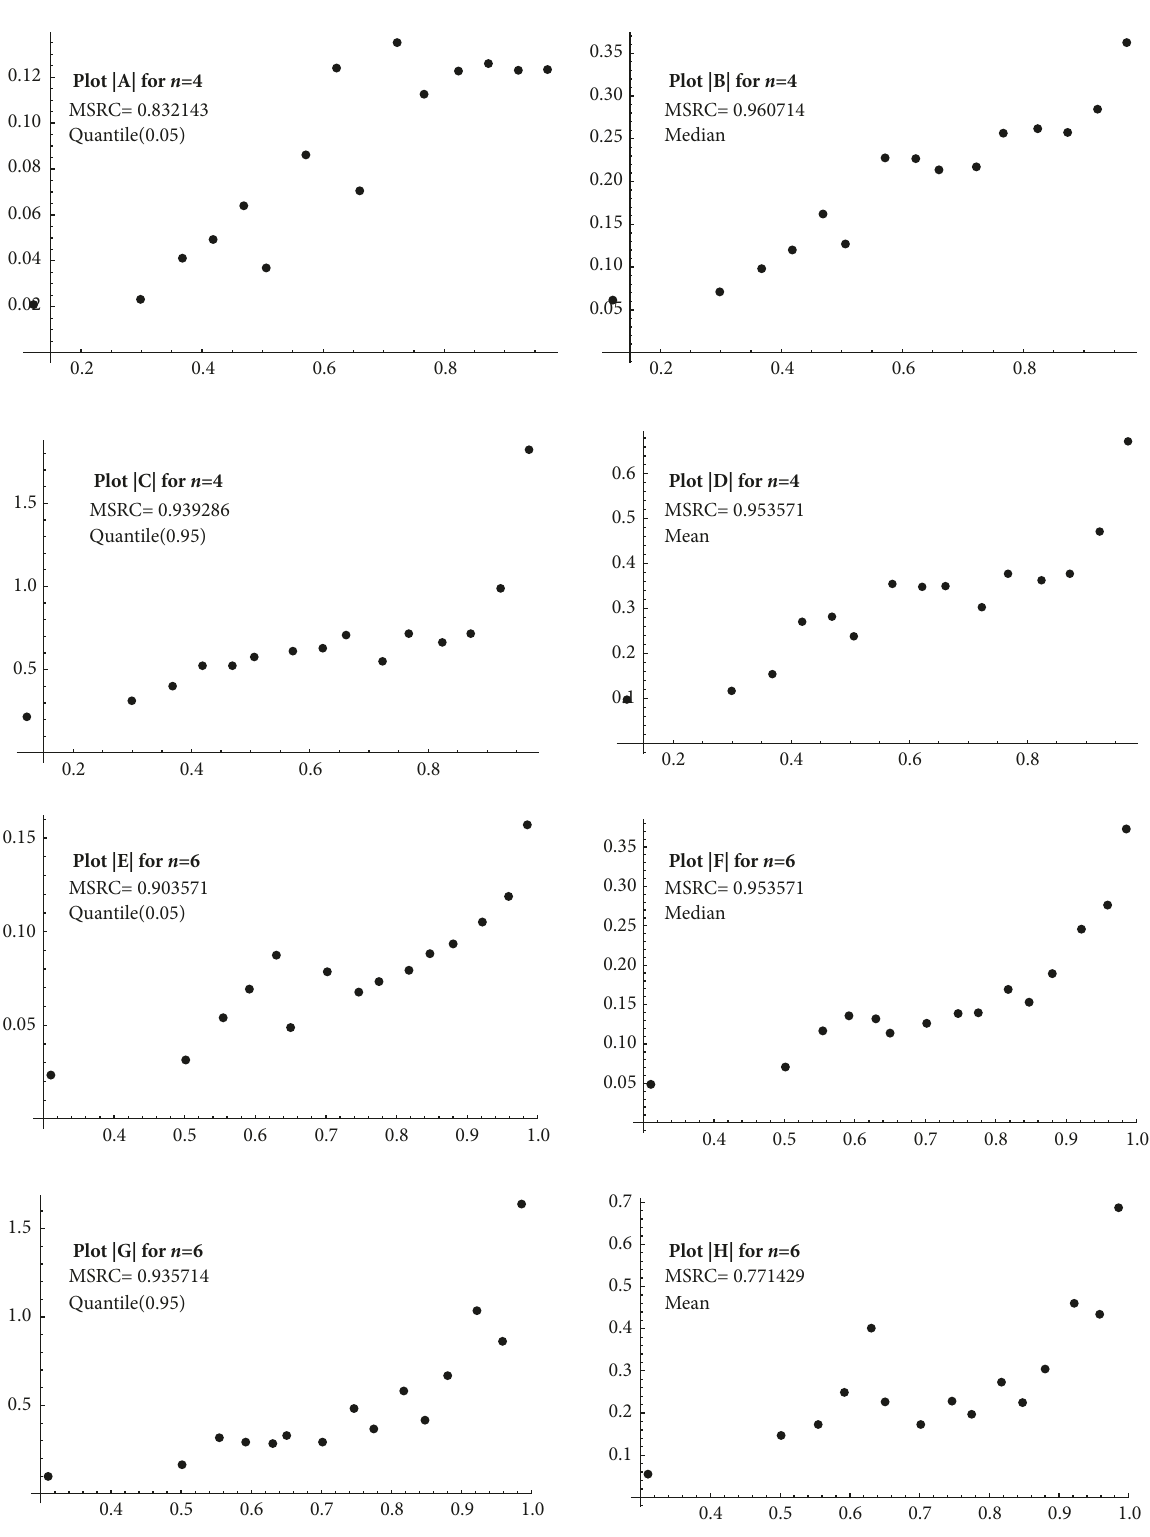
Figure 2: Performance of K ( A ) as PCM-CM . The plots present the relation between mean values of K ( A ) within a given interval (VRCM n ) and values of MREs and quantiles of a given order for MREs distribution concerning estimated and true PV for the case. The results are generated with application of LLSM as the PP and geometric scale , i.e., 𝑓(𝑛) = 𝑐 𝑛/2 for 𝑛 ∈ {−8,. .. ,8} ∧ 𝑛 ∈ 𝐼 as the preference scale with its most popular parameter c= 2. Plots are based on 10,000 random reciprocal PCMs for n =4 and n= 6. MSRC denotes Mean Spearman Rank Correlation Coefficient between analyzed variables and describes their relation’s